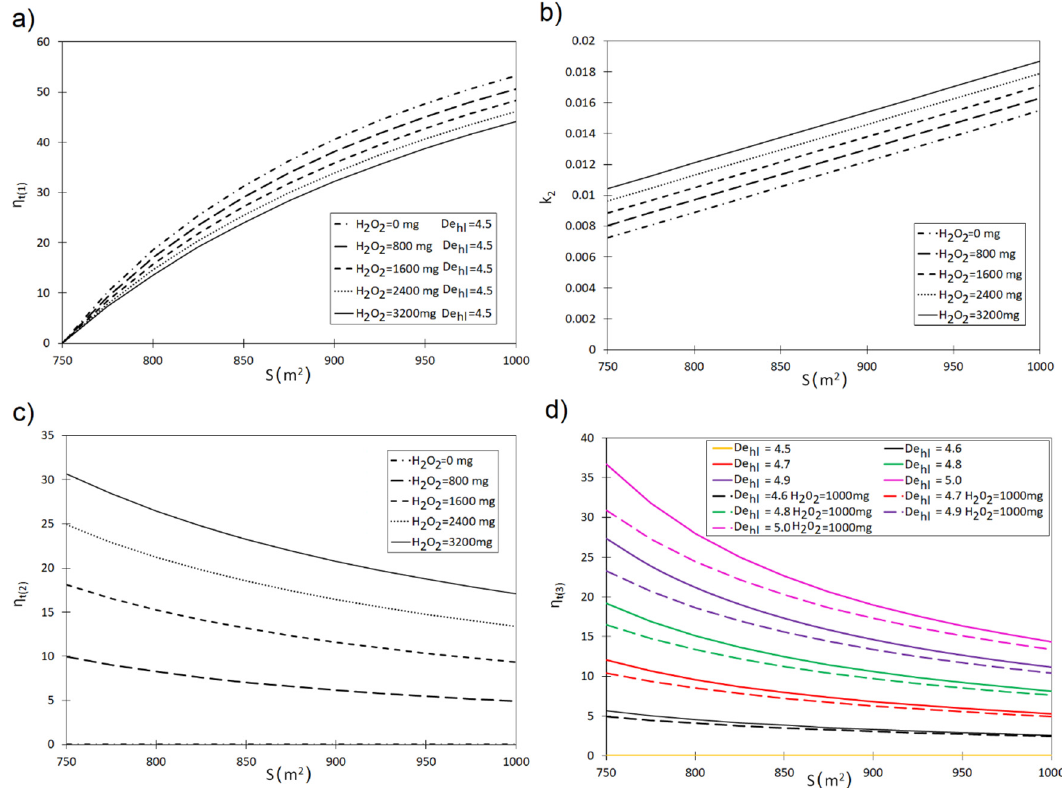
Figure 3. ( a ) Influence of specific surface of activated carbon (S) and oxidizer dose (H 2 O 2 ), for De hl = 4.5 on η (1) . ( b ) Influence of specific surface of activated carbon (S) and oxidizer dose (H 2 O 2 ) for De hl = 4.5 with reaction rate constant k 2 in pseudo-second order equation. ( c ) Influence of specific surface of activated carbon (S) and oxidizer dose (H 2 O 2 ) for De hl = 4.5 on η (2) . ( d ) Influence of specific surface of activated carbon (S), oxidizer dose (H 2 O 2 ), and dechlorination half-length (De hl )on η (3) .